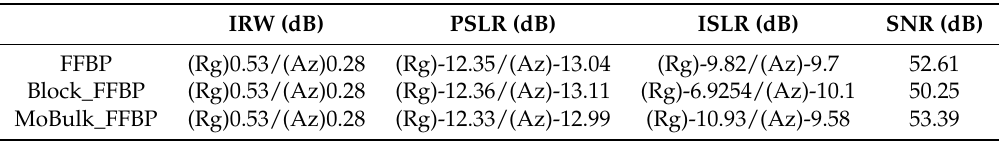
Table 2. Accuracy measurements. IRW, impulse-response width; PSLR, peak sidelobe ratio; ISLR, integrated sidelobe ratio; Az, azimuth; Rg,